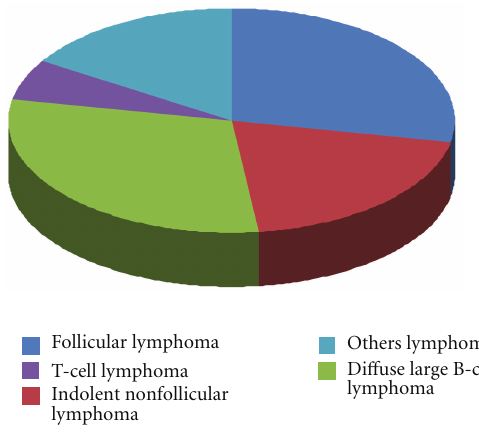
Figure 1: Incidence of Non-Hodgkin